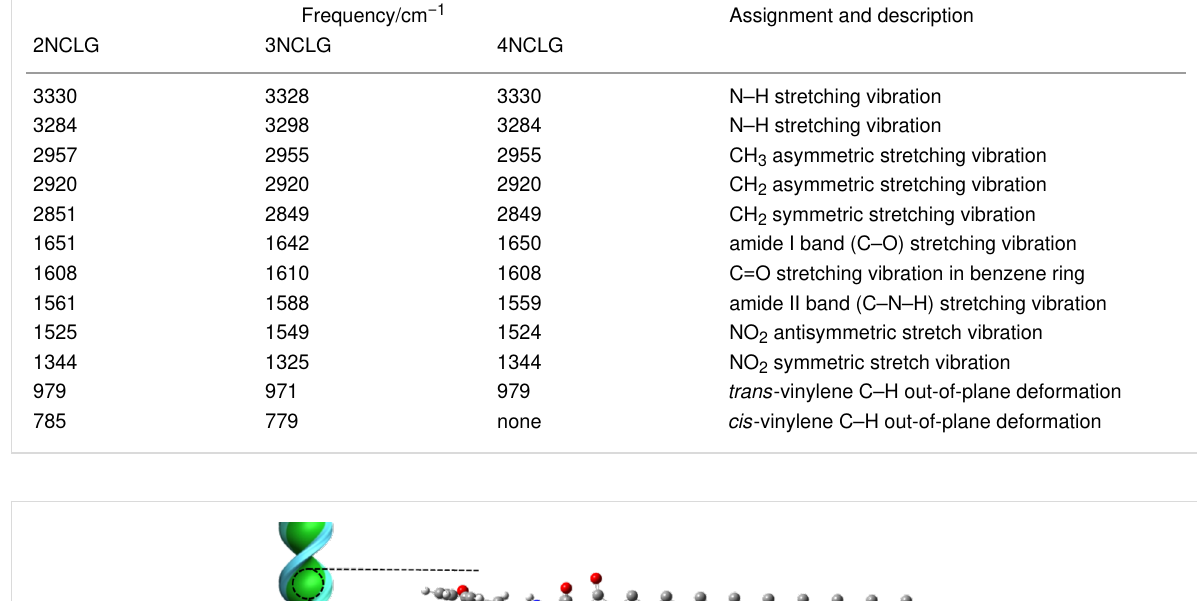
Table 1: Assignment and description of FTIR absorption bands of the three NCLG assemblies.